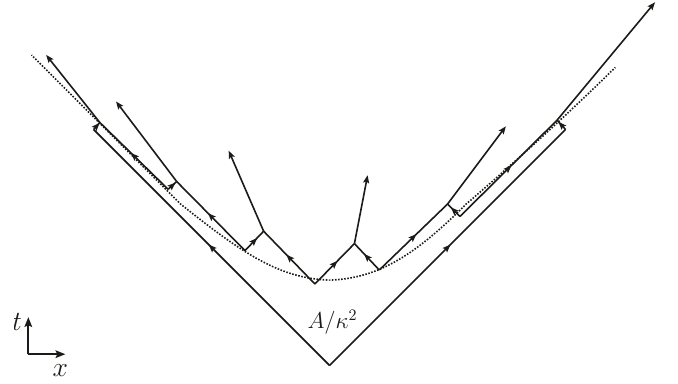
Figure 2 . Breakup of a string between a quark and an anti-quark in a x − t diagram. New q ¯ q pairs are produced around a hyperbola, and combine to the outgoing hadrons. The original q and ¯ q move along light-like trajectories. The area enclosed by the quark lines is the coherence area A in (3.1), in units of the string tension κ . The notion of the “hadronization time” is not well defined. It could be the time when the new q ¯ q pairs are produced, or when they meet for the first time to form a hadron (or something in